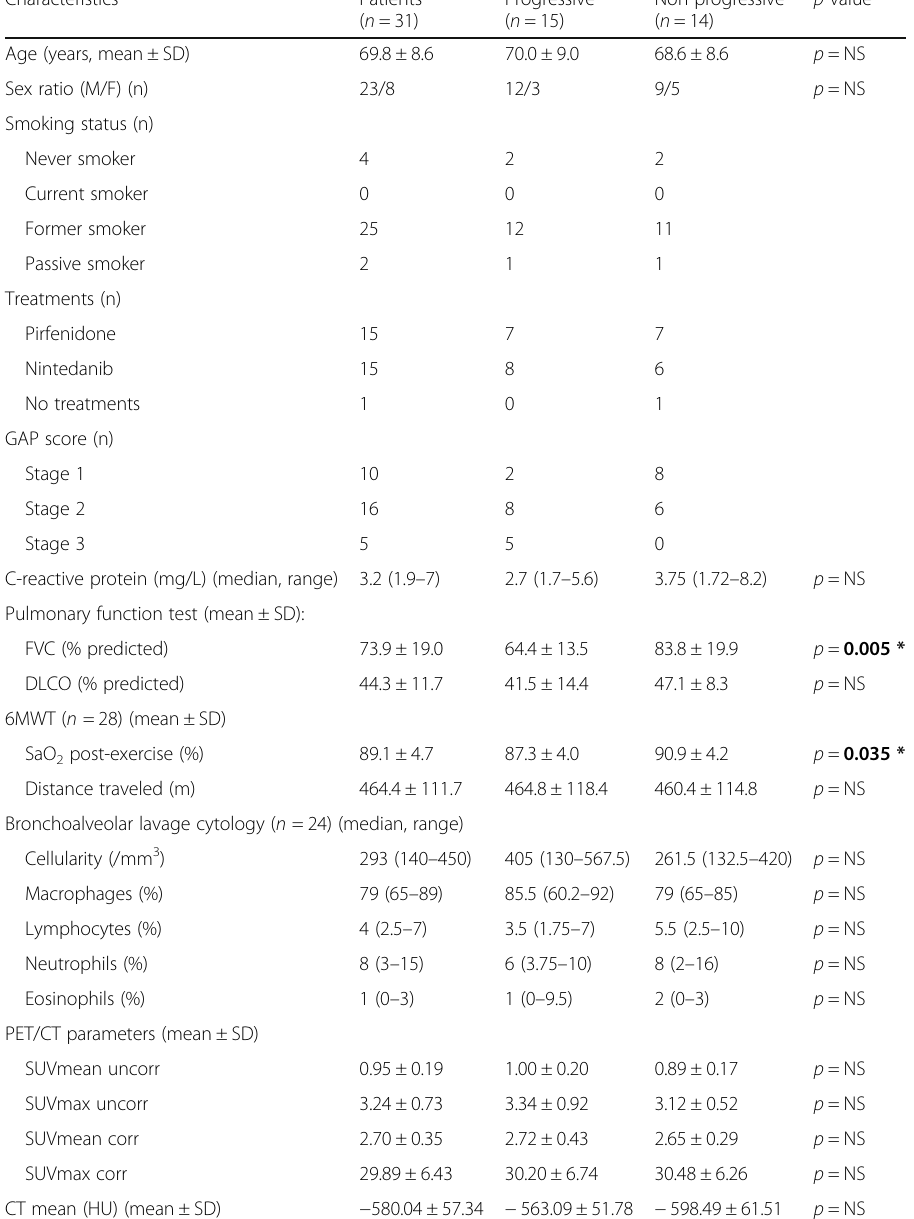
Table 1 Clinical and functional data for patients at baseline